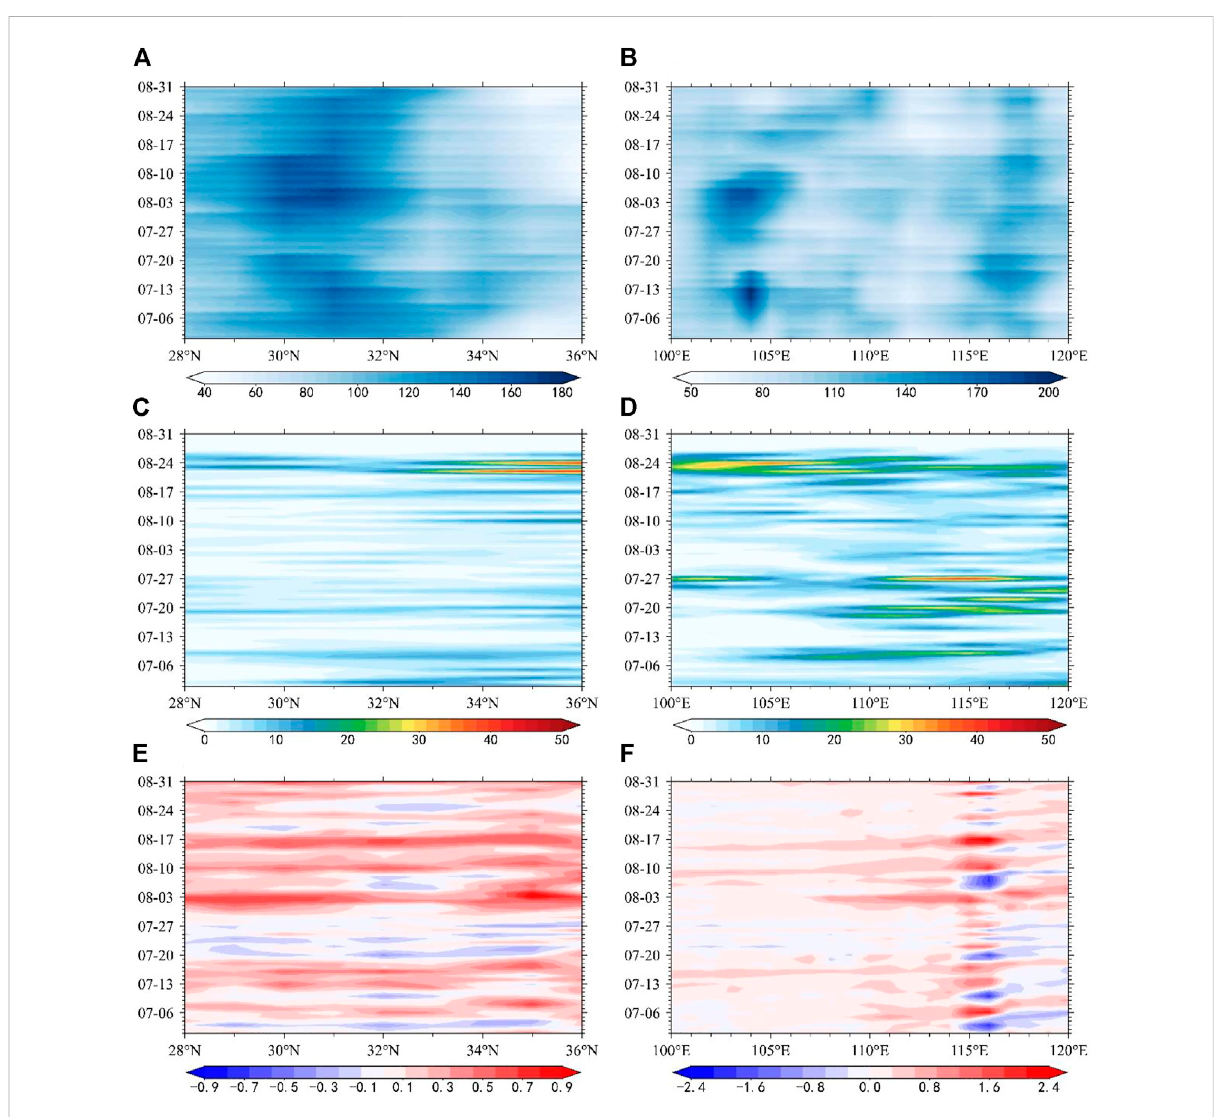
FIGURE 7 Latitude – time and longitude – time evolution of precipitation (A) , (B) (Units: mm); the transient disturbance kinetic energy k ′ (C) , (D) (Units: m 2 · s − 2 ) and diabatic heating (E) , (F) (Units: 10 − 4 K day − 1 ) within 28 ° N – 36 ° N, 100 ° E – 120 ° E in July to August